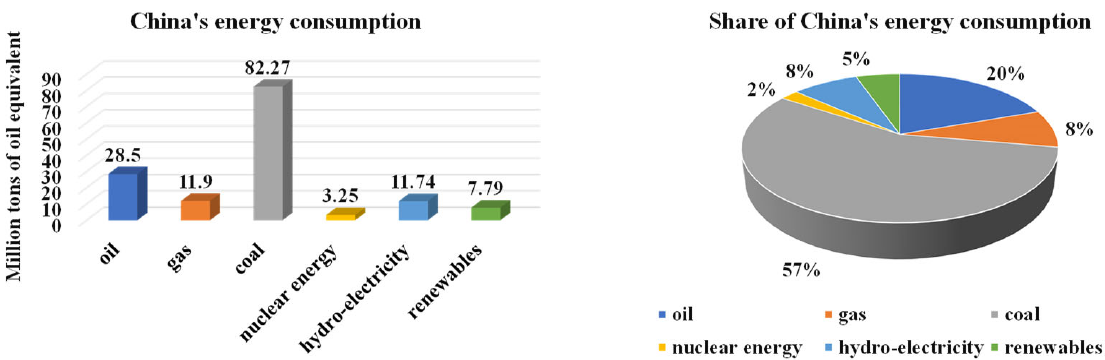
Figure 2. Proportion of China’s energy consumption in 2020.